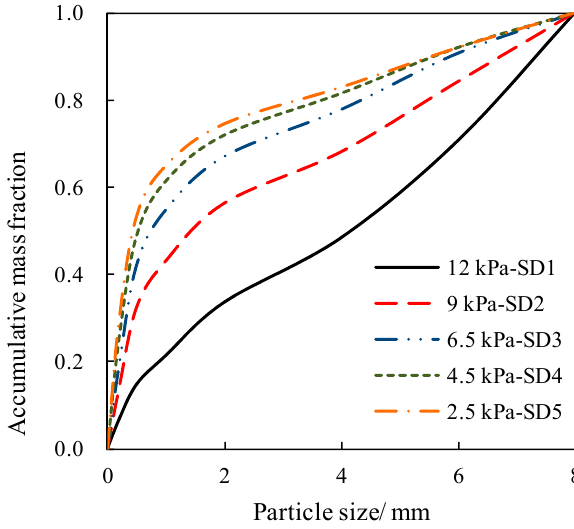
Figure 8. Coal particle size distribution corresponding to different bed pressure drop.